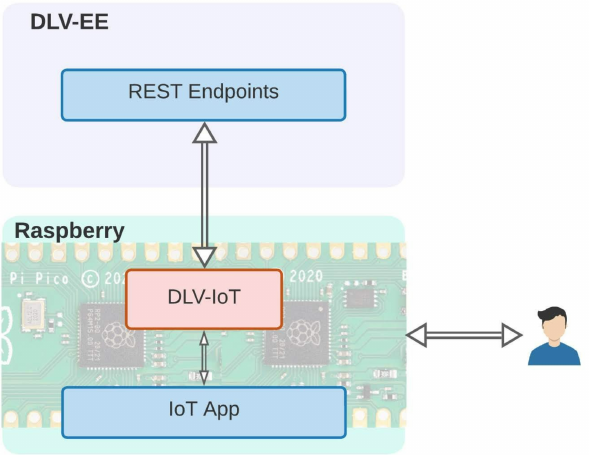
Figure 2. Typical architecture of a DLV-IoT-based application over